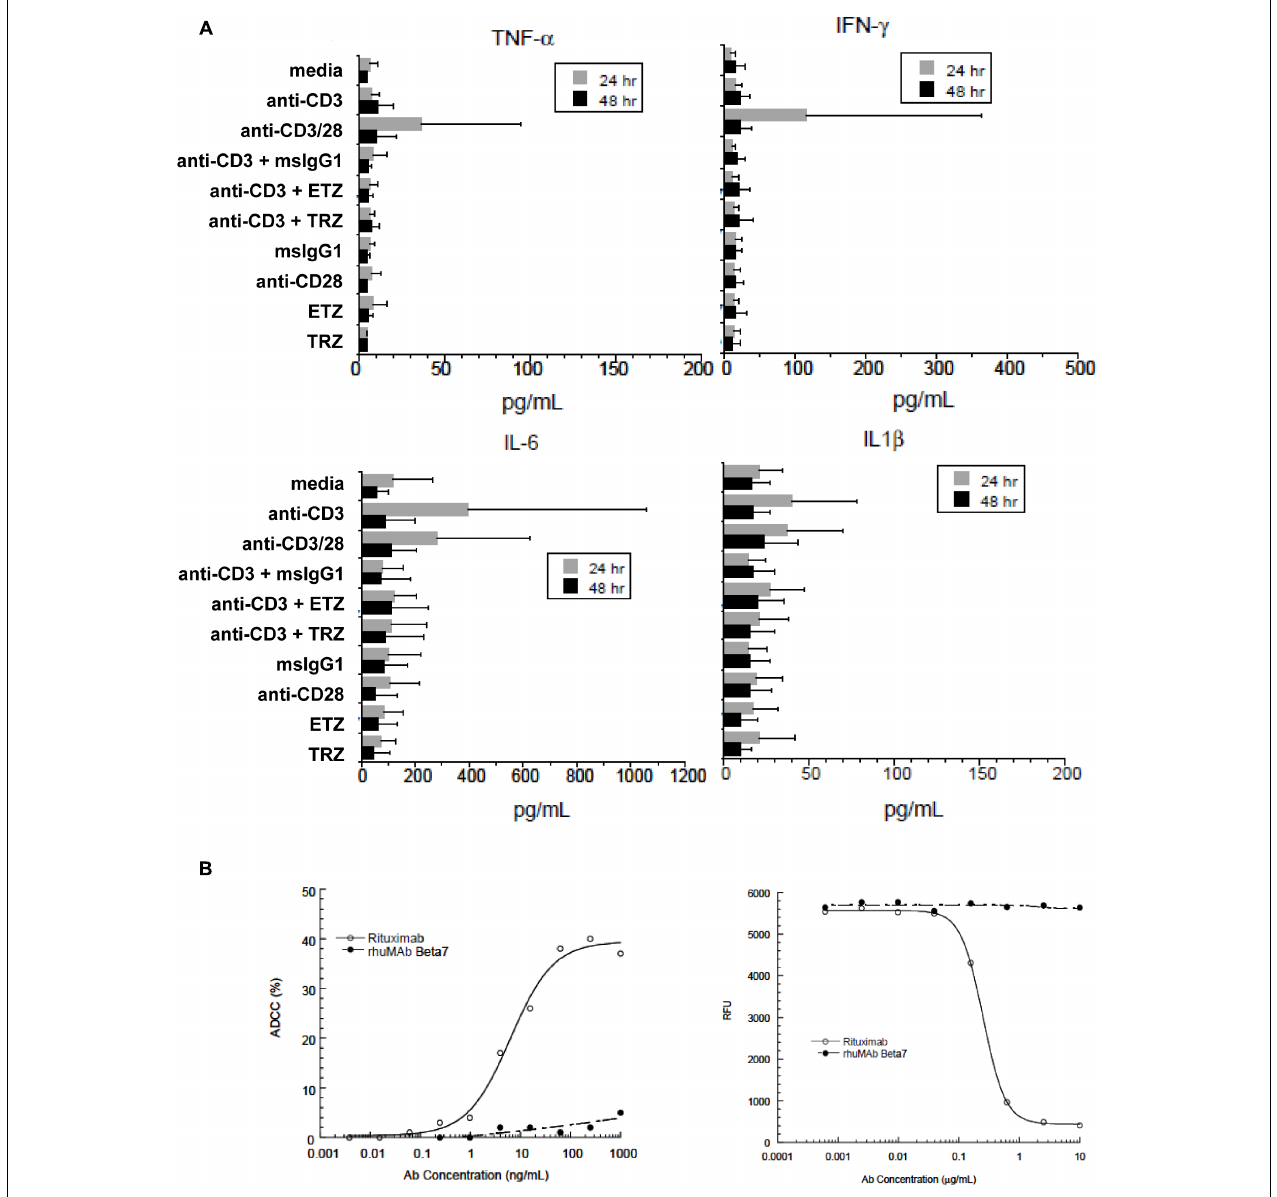
FIGURE 8 | Etrolizumab does not elicit cytokine production and cytotoxicity. (A) Concentration of cytokines in supernatants of human PBMCs incubated with different antibodies with or without stimulation with anti-CD3 after 24 and 48 h. n = 6, mean +/– SD. (B) Left panel: ADCC activity of different concentrations of etrolizumab (rhuMAb Beta7) and rituximab in WIL2-S cells quantified as specified in Methods. Right panel: CDC assay with different concentrations of etrolizumab and rituximab in WIL2-S cells as specified in Methods. Relative fluorescence units (RFU) indicate the number of viable cells. Data are representative for three independent